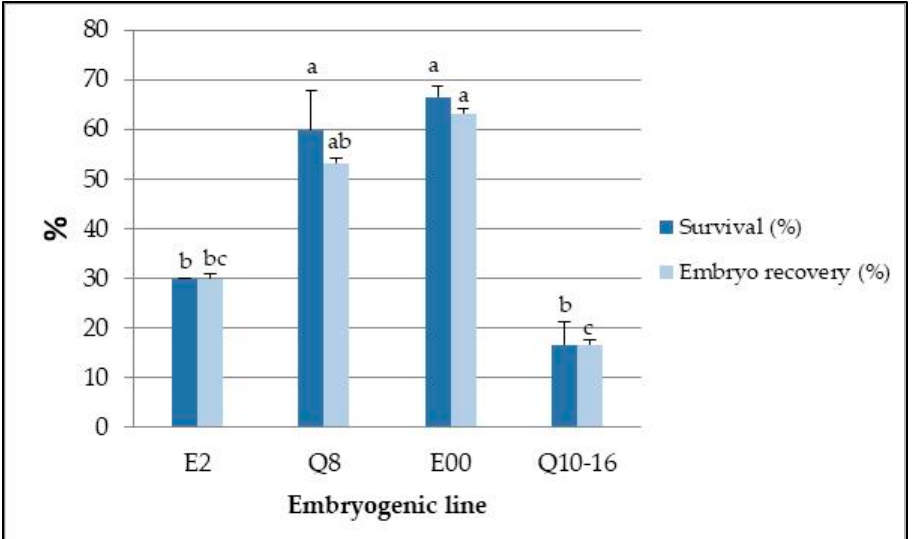
Figure 2. Survival and embryo recovery rates of four holm oak embryogenic lines after four years in LN. In each embryogenic line, columns represent means ± standard error of three replicates. Different letters on the bars indicate significant differences (at p = 0.05).